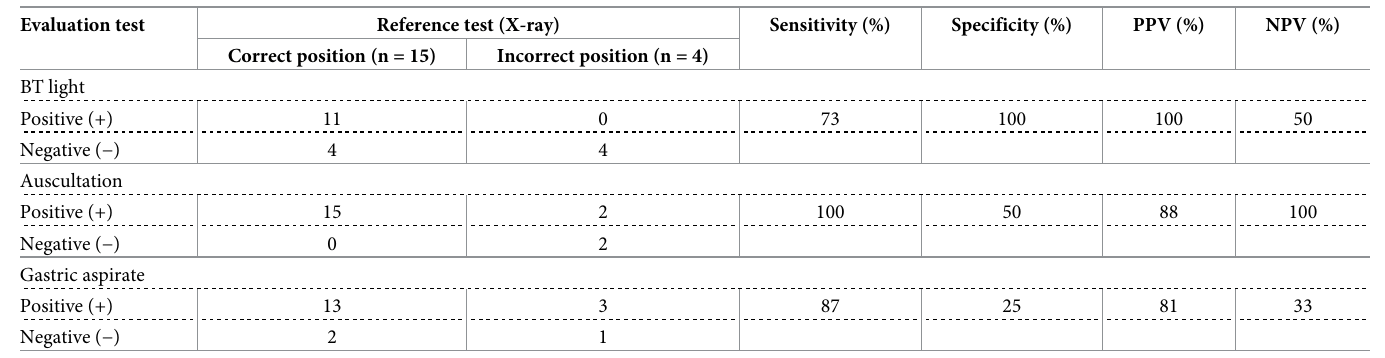
Table 3. Results of diagnostic tests in obese